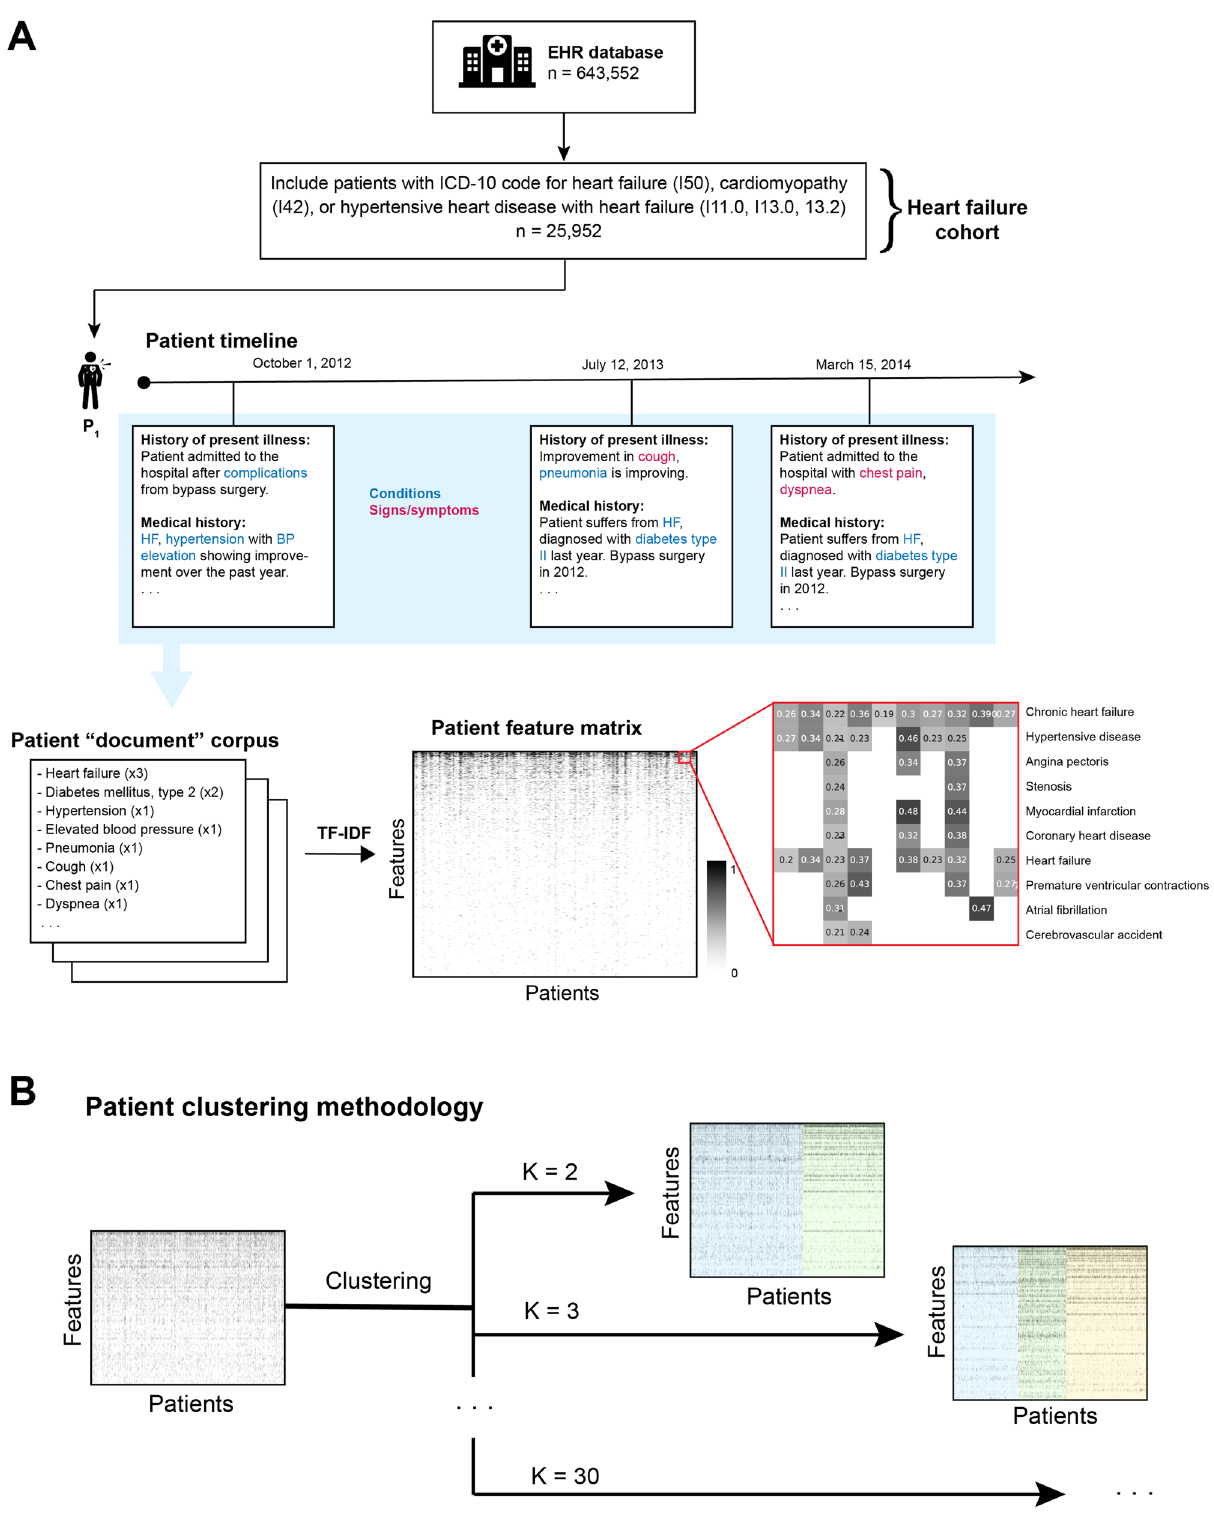
Figure 1. Workflow diagram depicting cohort definition and vectorization of EHRs. ( A ) The final cohort consists of 25,952 individuals with heart failure. An NER system was used to extract condition and symptom mentions in the clinical notes. These were aggregated over the entire timeline of each patient. The resultant “corpus” (medical concept counts for each patient) was then transformed using TF-IDF to obtain a vector space representation of patient EHRs. ( B ) Schematic of patient EHR clustering methodology. The patient- feature matrix derived from patients’ clinical notes in ( A ) was used to fit K-means clustering models for values of K in [2, 3, …, 30]. Examples of clustering results are shown at right for K in [2, 3], with cluster assignment highlighted with colored